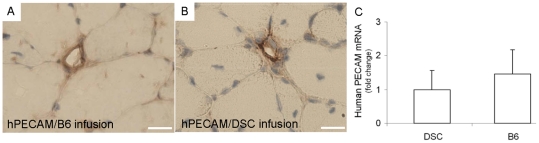
Contribution of transplanted myogenic clones and their parent stem/progenitor cells to angiogenesis.Immunolocalization of human-specific PECAM to a representative blood vessel (A) showing human cell derived endothelium upon infusion of a myogenic clone (B6). Similarly, infusion of heterogeneous stem/progenitor cells (DSC) also yielded human specific PECAM-positive blood vessel (B). Scale: 20 µm. C: Quantitative real-time PCR analysis showed a lack of significant differences in mRNA expression of human-specific PECAM by B6 and DSCs (p>0.05). Y axis represents fold change relative to heterogeneous DSCs.